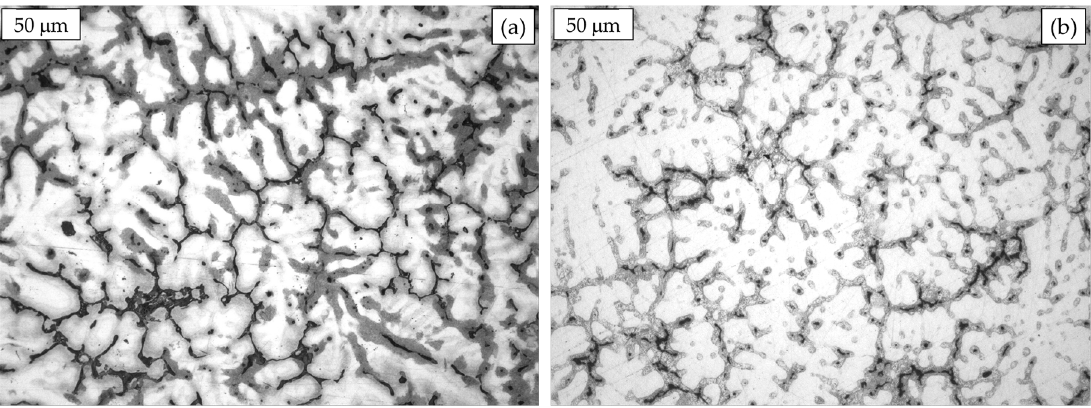
Figure 5. Hyper-eutectoid ZA27 ( a ) and Alzen 305 microstructures ( b ).